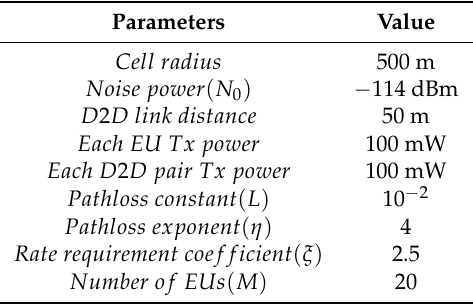
Table 4. Simulation Configure